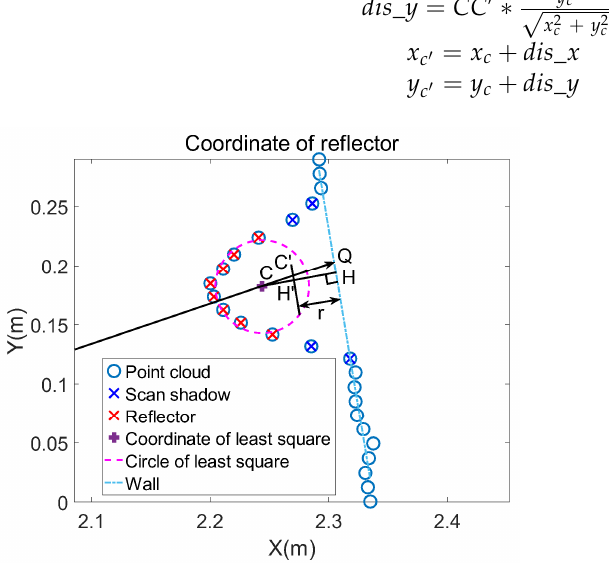
Figure 11. The reflector is placed close to the wall. The distance between the circle center and the wall equals the radius. Therefore, move the rough circle center to a point whose distance from the wall is radius.